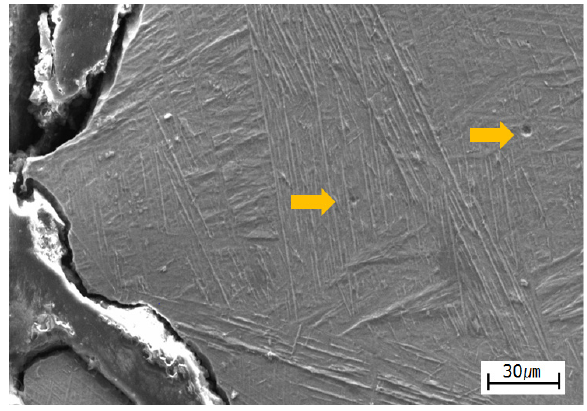
Figure 11. SEM image of cracked Ti ‐ 3Al ‐ 2.5V pipe weldment: yellow arrows indicate pores.